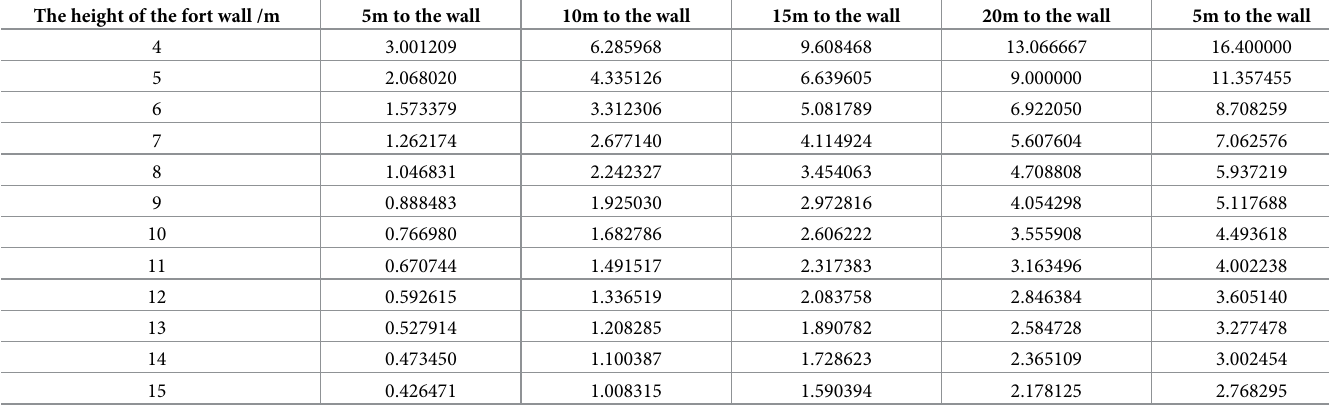
Table 7. Sheet of the width of the firing blind area of ten-Chi Yangmacheng. The height of the fort wall